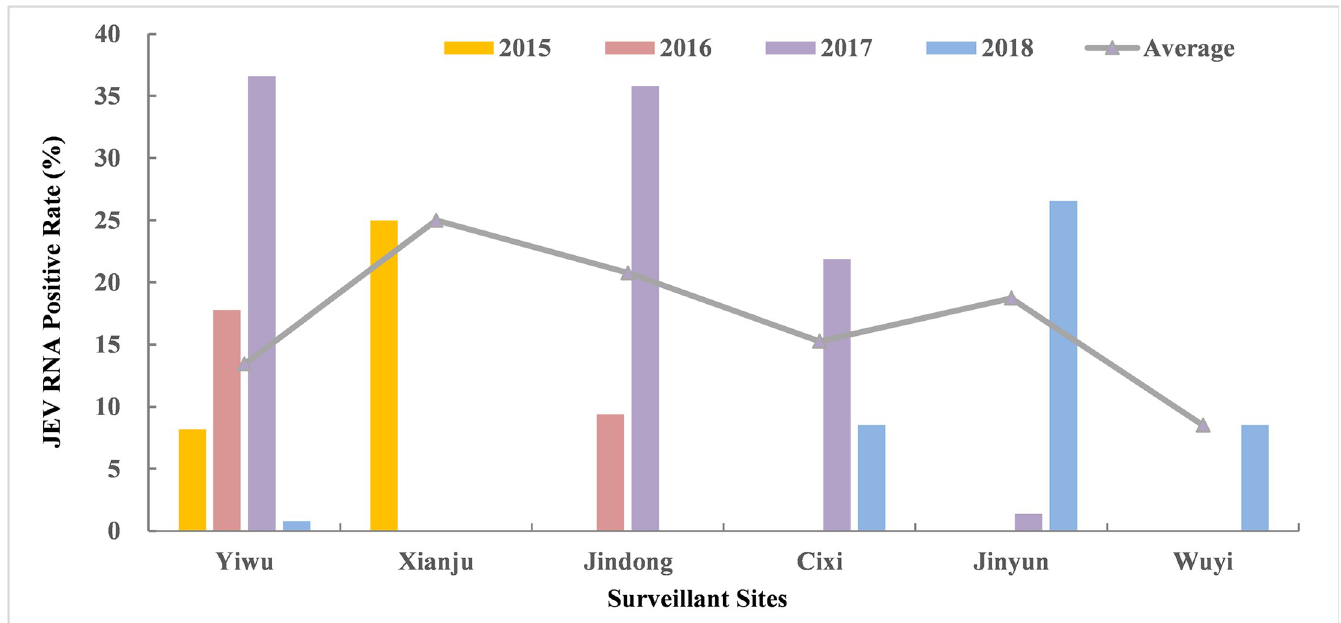
Fig 3. JEV RNA positive rate among Culex tritaeniorhynchus of mosquito surveillance sites in Zhejiang, 2015–2018.